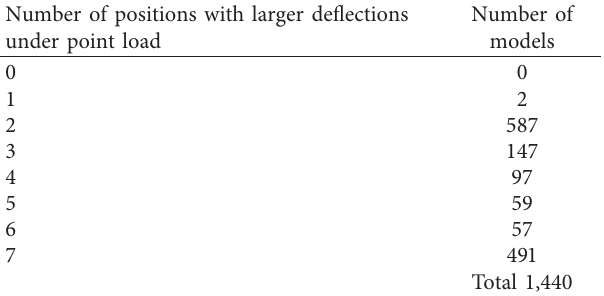
Table 2: Number of models with larger deflections under point